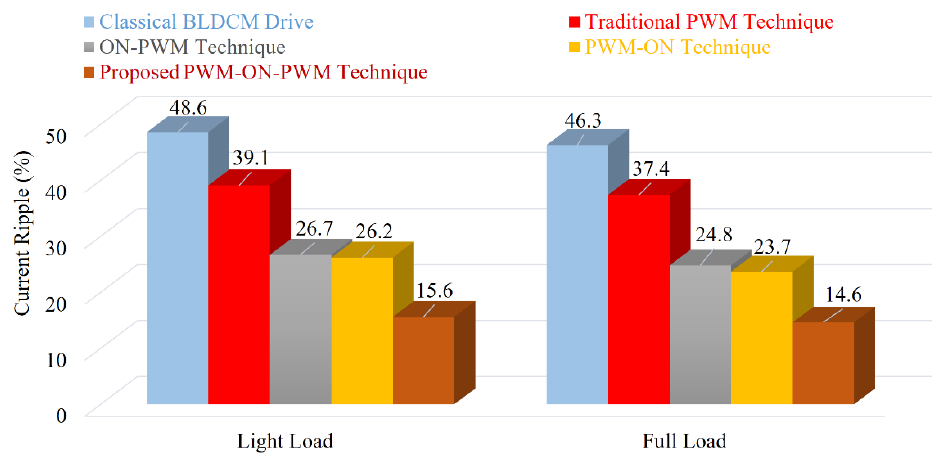
Figure 22. Experimental results of motor phase current and MSEPIC converter current during the dynamic conditions: ( a ) load increases; and ( b ) load decreases suddenly.